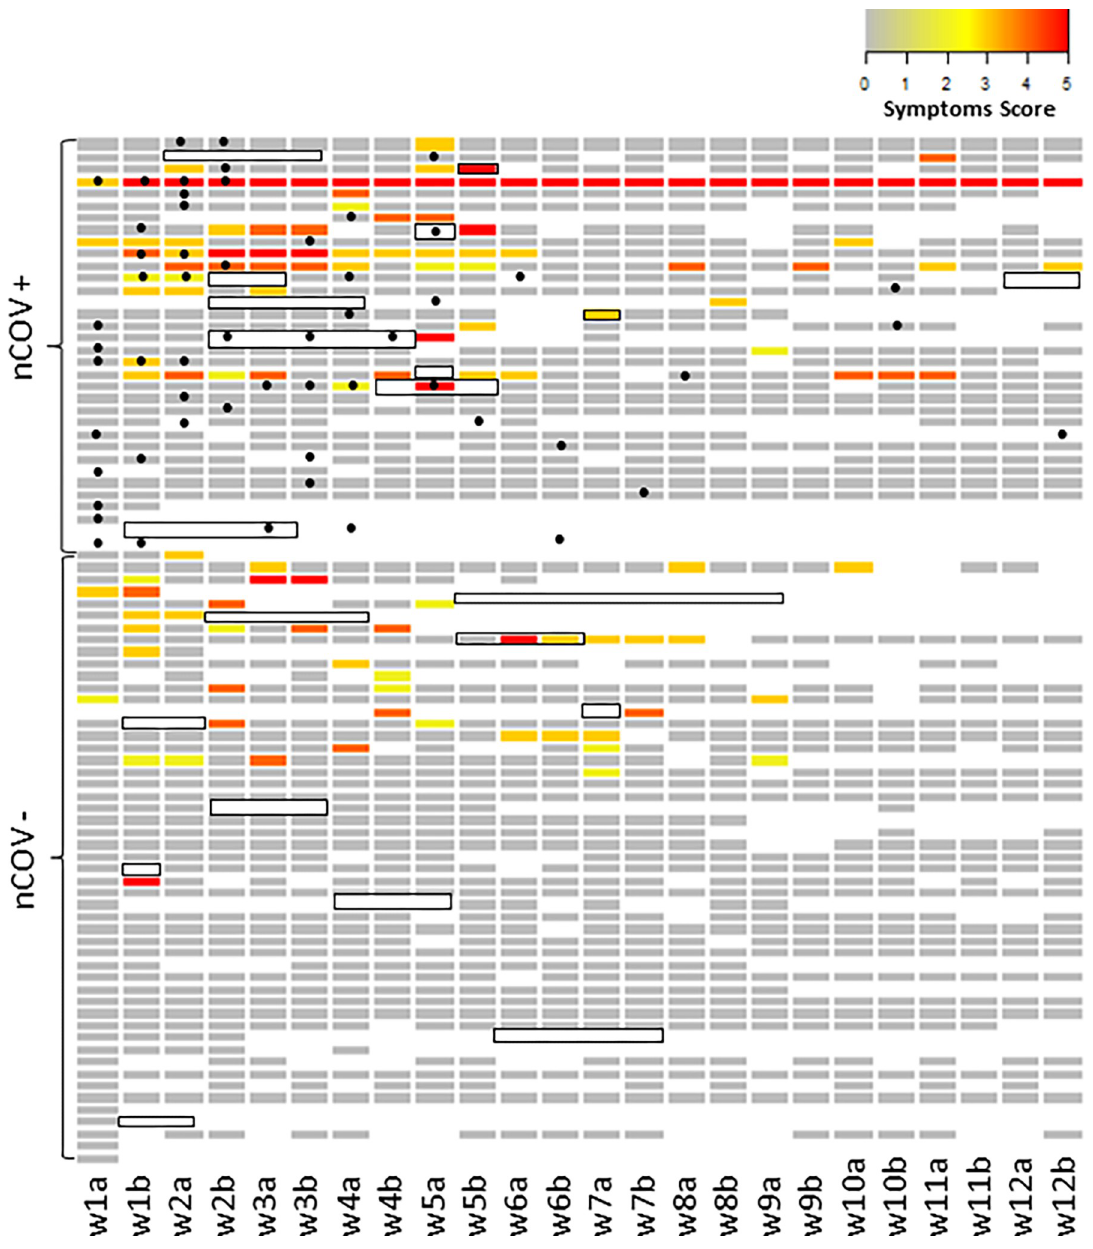
Fig 1. Symptoms, isolation and SARS-CoV-2 RNA status in HCW (n = 85) over a period of 12 weeks. Heatmap for recorded symptoms using a colour scale to represent symptoms score (see Box 2) from grey (0: Asymptomatic) to red (5: A symptom consistent with the COVID-19 case definition in red). No participants scored 6. The participant with symptoms recorded at every timepoint experienced loss of smell which persisted throughout the study period. Isolation period is indicated by a black box delineating timepoints (week 1–12). Participants were clustered into two groups, nCoV+ (positive for SARS-CoV-2 RNA by either diagnostic method), or nCoV- (SARS-CoV-2 RNA negative on results available). Timing of positive results are indicated by a black dot. First and second samples per week are labelled “a” and “b” respectively. Time points with missing data are shown in white. symptoms associated with a positive SARS-CoV-2 results to be 50.0% (15/30). In participants with evidence of SARS-CoV-2 infection attending work, symptoms were predominantly respi- ratory (coryza, sore throat, cough) but most often not those included in the COVID-19 case definition.